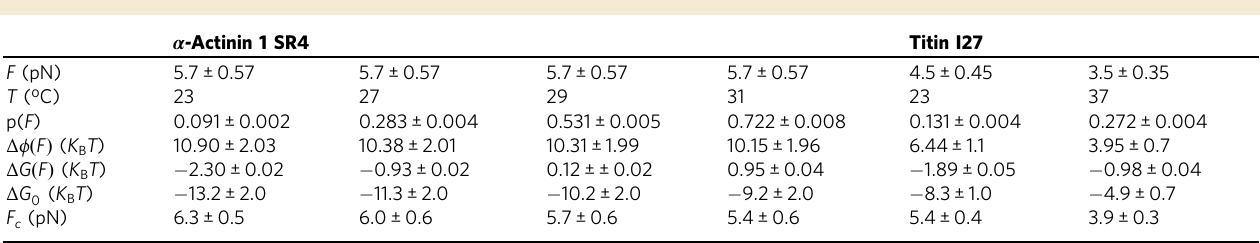
For α -actinin1SR4domain,experimentswereperformedatfour differenttemperatures(23,26,29,and31°C)at aconstantforce of5.7pN.FortitinI27domain,experimentswereperformedat37°Cat a constant force of 3.5pN. Thedatafor titin I27at 23°C at a constant force of 4.5pN were taken frompreviouspublications 27,31 forcomparison.The errorbars (s.t.d.)for p ( F )are obtained by bootstrap analysis; for ΔΦ ( F ) are obtained by error propagation from the 10% of relative uncertainty in force-calibration ( “ Methods ” ); for Δ G ( F ) are obtained by error propagation from the error bars of p ( F ); for Δ G 0 are obtained by error propagation from the error bars of ΔΦ ( F ) and Δ G ( F ); for F c are obtained by error propagation from the error bars of Δ G 0 . Source data are provided as a Source Data fi Table 1), and revealed that the stability of the spectrin-repeat is negatively in fl uenced by increased temperatures.